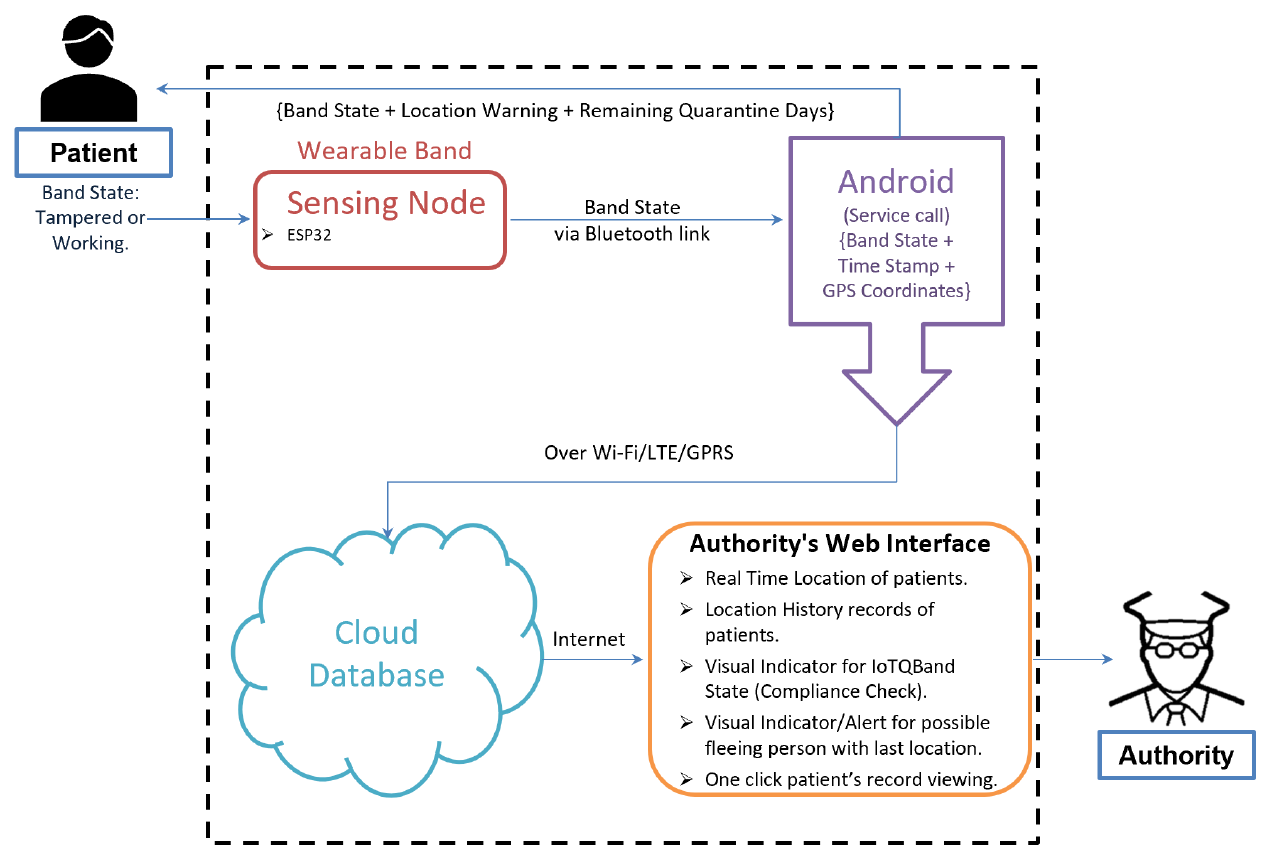
Figure 1. System architecture of the IoT-Q-Band